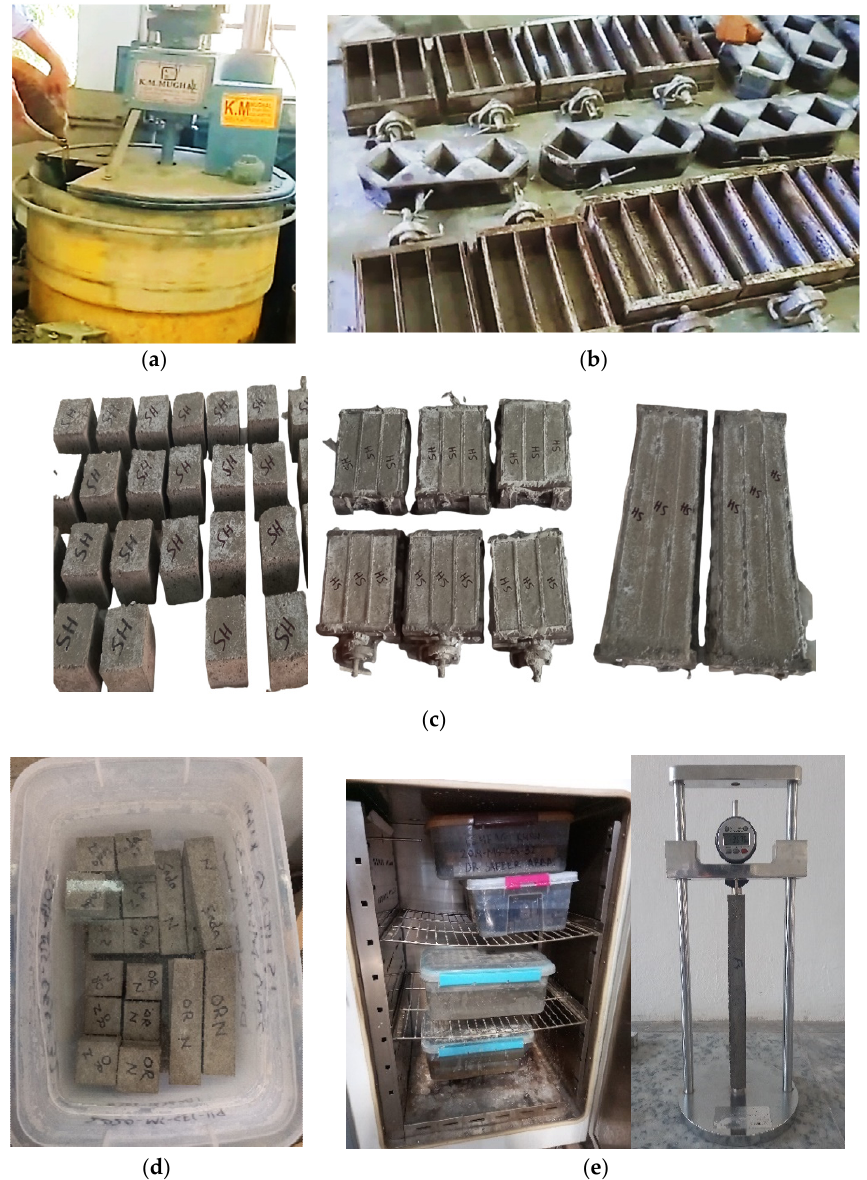
Figure 2. Specimen preparation and testing ( a ) Electrical mixer; ( b ) molds placed on vibratory table; ( c ) casted specimens; ( d ) specimens placed in ASR solution; ( e ) specimens placed in oven and testing using digital length comparator.